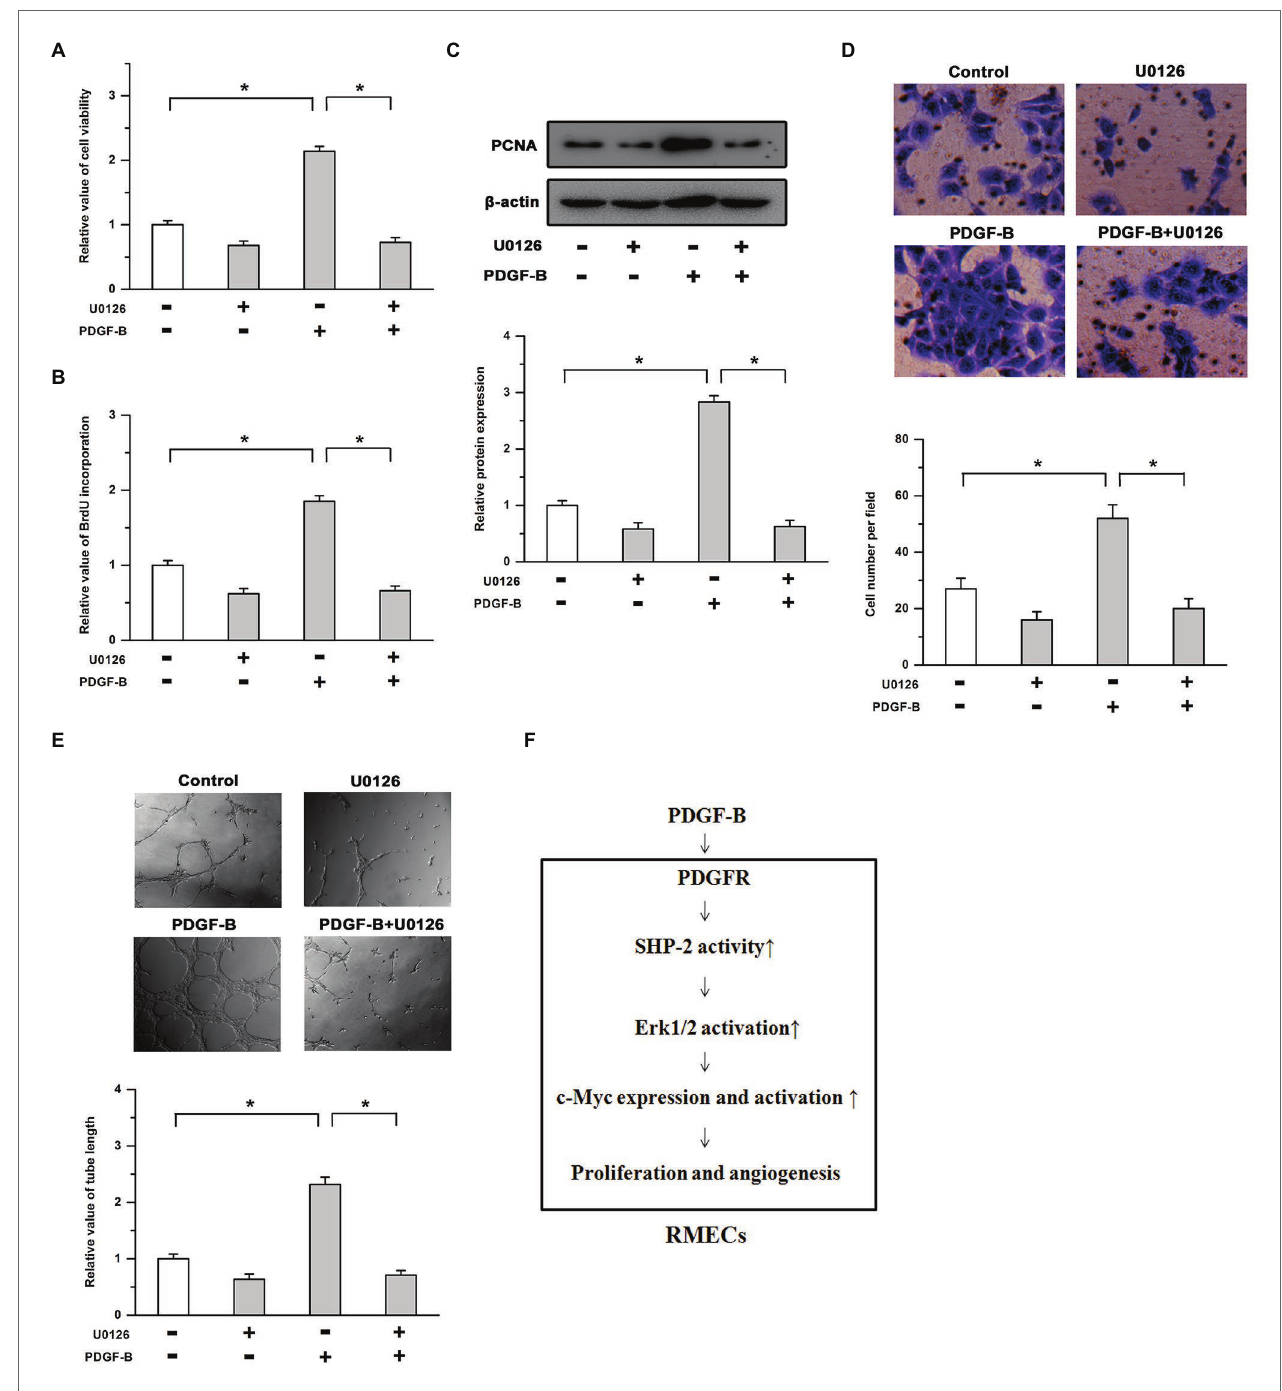
FIGURE 5 | The roles of PDGF-B in cell proliferation and angiogenesis are attenuated by inhibition of the Erk pathway. (A,B) The increases in cell viability (A) and BrdU incorporation (B) induced by PDGF-B were abolished by U0126. (C) The increased expression of PCNA induced by PDGF-B was weakened by U0126. (D,E) The cell migration (D) and tube formation (E) enhancements induced by PDGF-B treatment were antagonized by inhibition of the Erk pathway. (F) A schematic representation of PDGF-regulated cell proliferation and angiogenesis in retinal microvascular endothelial cells (RMECs) is shown. *indicates p <